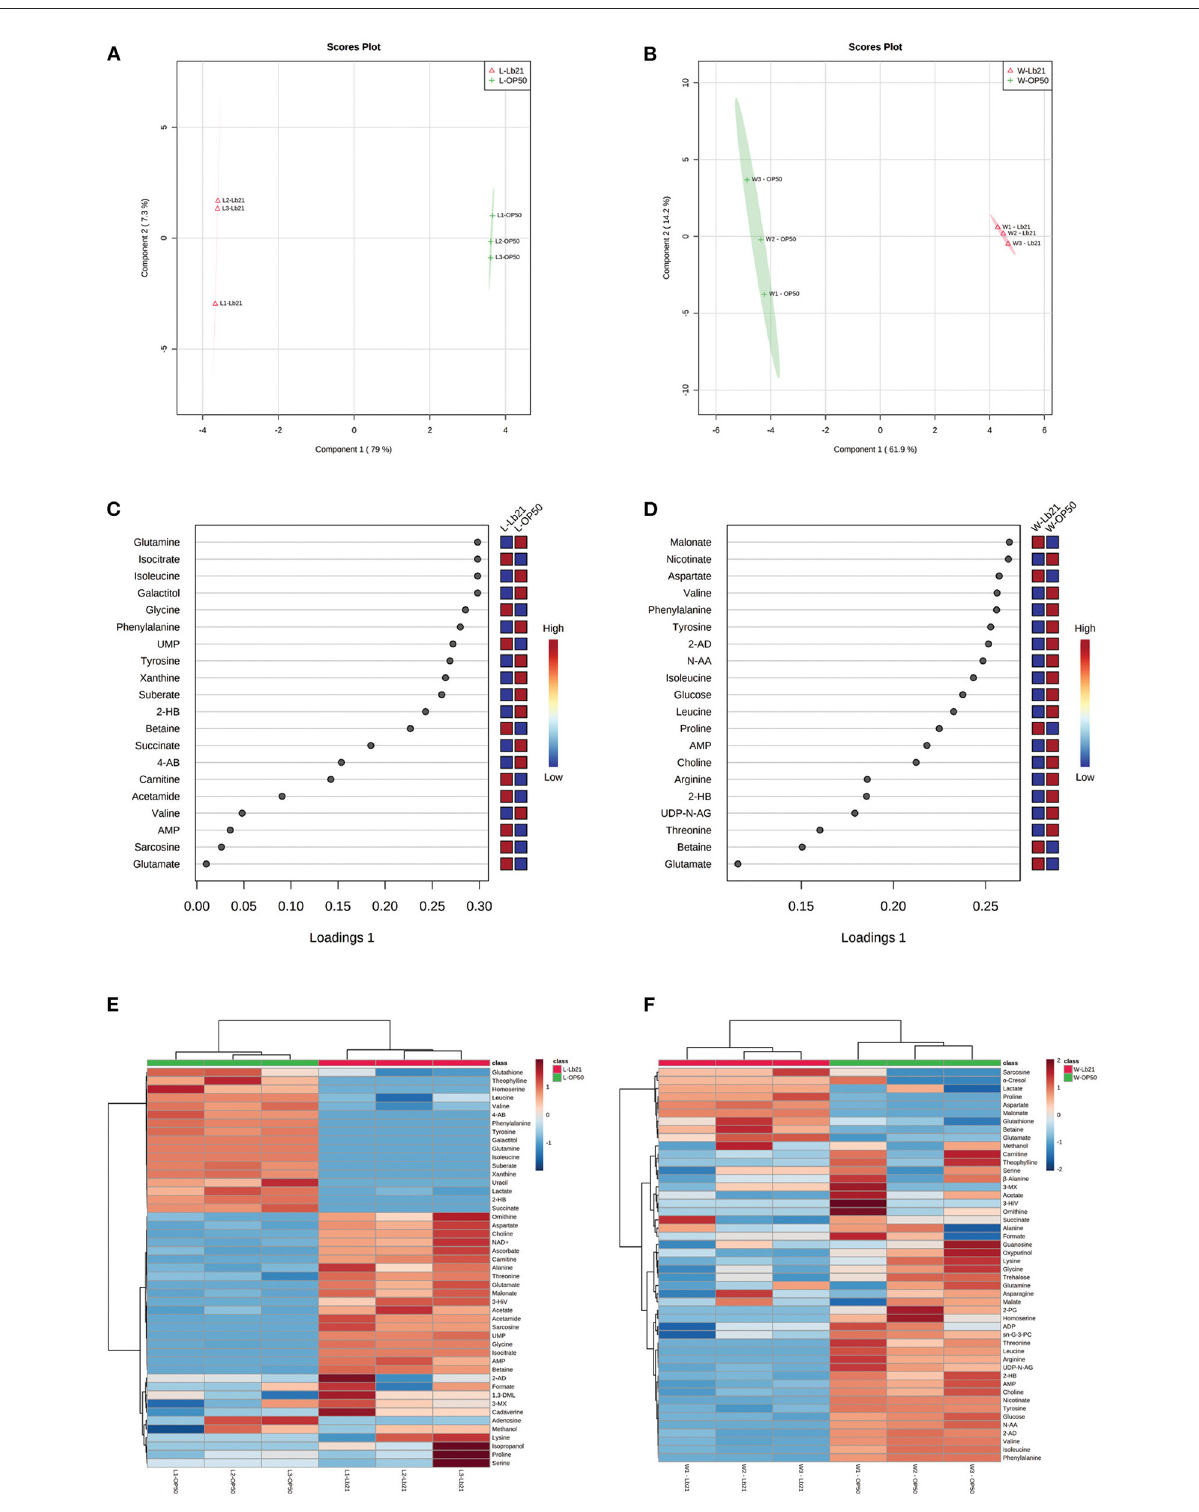
FIGURE3 sPLS-DA and hierarchical clustering analysis: sPLS-DA score plot and loading plot from bacterial lawn samples and from worms fed the two different bacteria. (A) sPLS-DA score plot from E. coli strain OP50 (L-OP50, green) vs. Lactobacillus spp. Lb21 (L-Lb21, pink). (B) sPLS-DA score plot from worms fed different bacteria, E. coli strain OP50 (W-OP50, green) vs. Lb21 (W-Lb21, pink). (C) Loading plot from the bacterial strains, L-OP50 vs. L-Lb21 (D) Loading plot from worms fed OP50 or Lb21 (W-OP50 vs. W-Lb21). Hierarchical clustering analysis highlighted significant differences between bacterial lawn groups, L-OP50 vs. L-Lb21 (E) ; and worms fed the two different bacteria groups, W-OP50 vs. W-Lb21 (F)